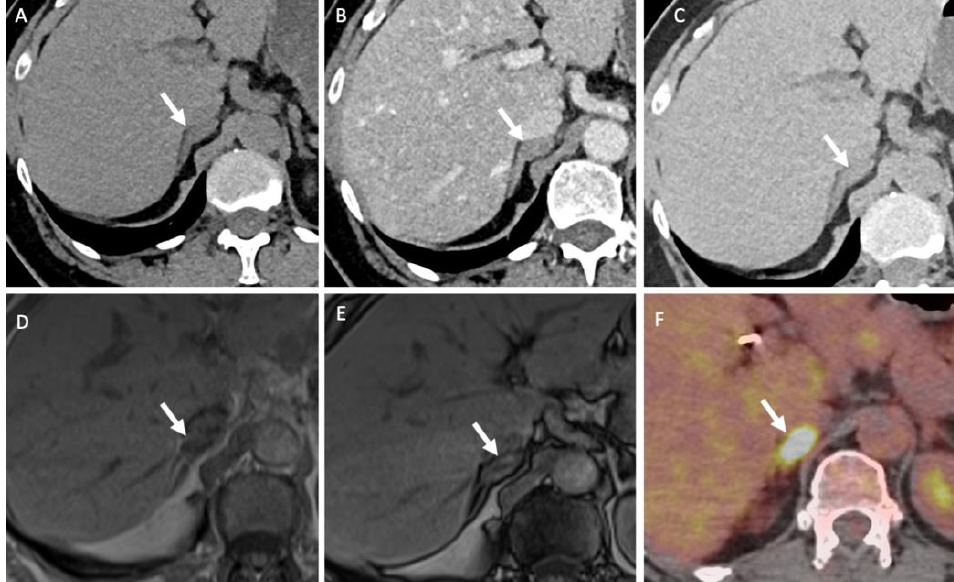
Figure 6. A 51-year-old man with a right adrenal nodule discovered during the initial staging of skin melanoma. Unenhanced ( A ) and contrast-enhanced CT images obtained at 60 s ( B ) and 10 min ( C ) after intravenous administration of iodinated contrast material in the axial plane show a nodule (arrows) in the right adrenal body. The nodule has attenuation values of 30 HU in the unenhanced image, 55 HU at 60 s and 40 HU at 10 min; the absolute washout is 0.60 and the relative washout is 0.27, which are not associated with a typical benign adrenal lesion. The unenhanced T1-weighted in phase ( D ) and out-of-phase ( E ) MR images in the axial plane show no signal drop of the nodule (arrows) in the out-of-phase image. ( F ) The 18 F-FDG PET/CT image in the axial plane shows marked uptake of 18 F-FDG by the right adrenal nodule. The nodule has a maximal standardized uptake value (SUVmax) of 8.4 and a liver-to-adrenal ratio of 3.8. Histopathologic analysis of a biopsy specimen obtained from percutaneous biopsy confirmed melanoma metastasis to the right adrenal gland.